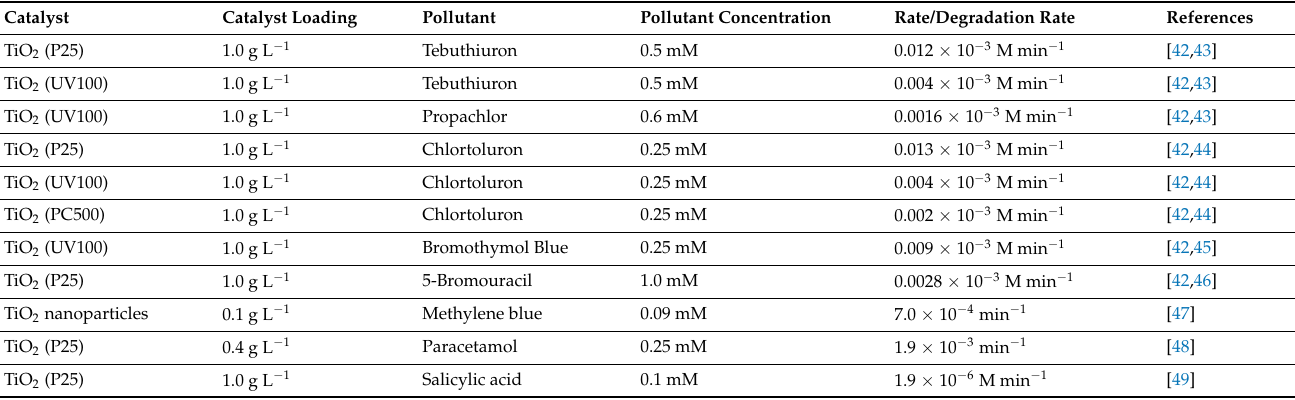
Table 3. Summary of some studies focusing on semiconductor photocatalysis for the degradation of organic